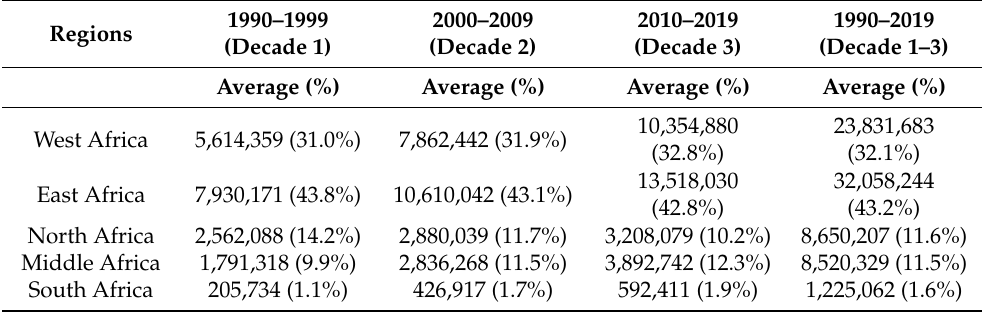
Table 1. Wood charcoal production (in tonnes) and percentages (%) by African regions in three decades